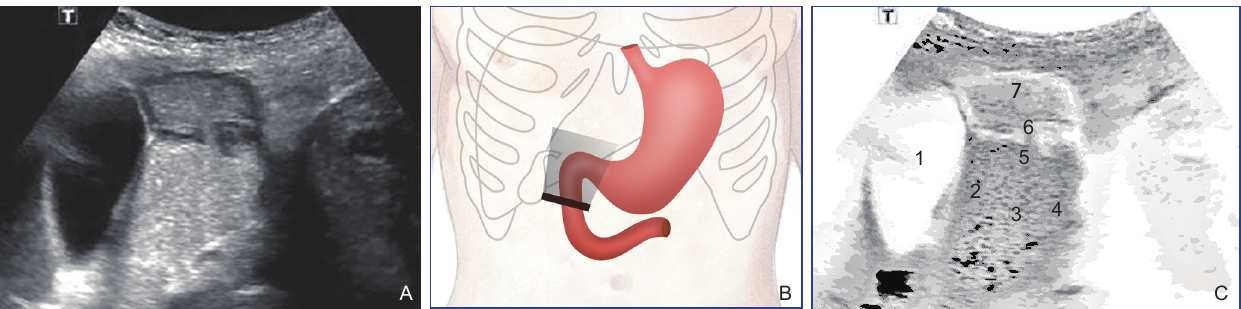
Figure 15 Ultrasonogram and schematic diagram of coronal section of the gastro-duodenal bulb (scan through the right upper abdomen) 。 A, Ultrasonogram; B, Schematic diagram; C, Schematic diagram of ultrasound (1, Gallbladder; 2, Lesser curvature side of the bulb; 3, Duodenal bulb; 4, Greater curvature side of the bulb; 5, Pyloric side of the bulb; 6, Pylorus; 7, Gastric antrum)